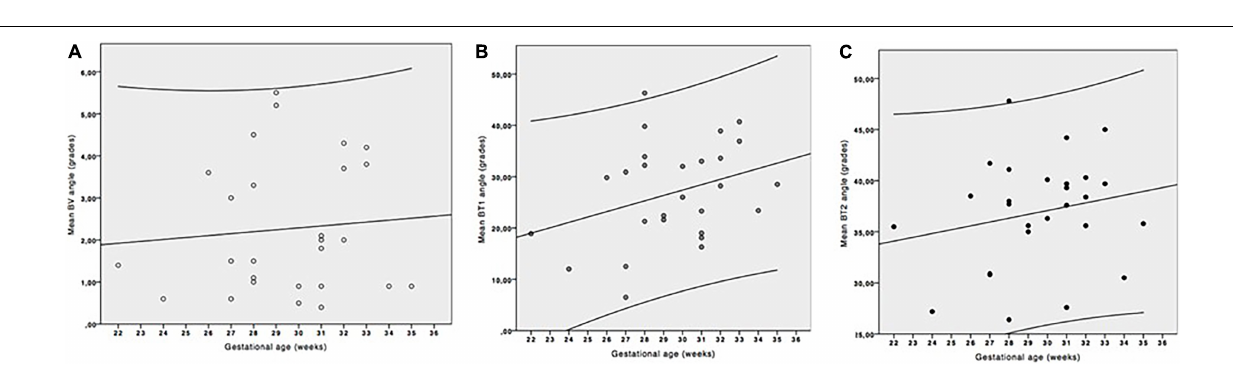
FIGURE 5 | Evolution of the brainstem vermis (BV) (A) and brainstem-tentorium (BT) (B) angles with gestational age (GA). (C) Evolution of the BV (empty dots) and BT (black filled dots) angles with gestational age. Only BT angle shows positive correlation with gestational age and predictive mean of BT angle (grades) = 1.20 × GA (weeks)-2.67; R 2 = 0.30; p =